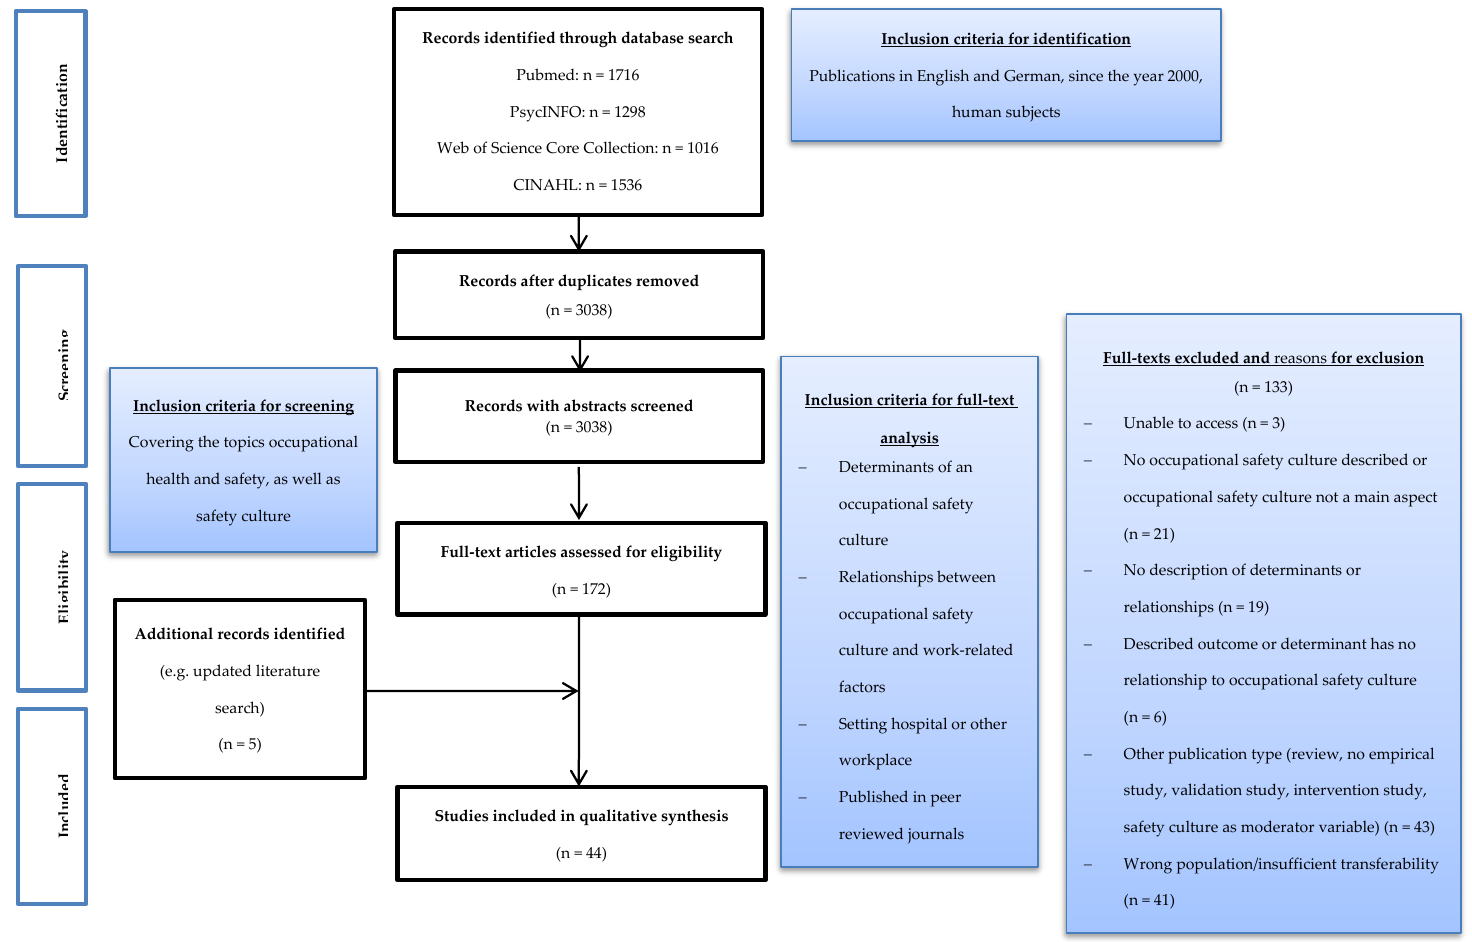
Figure 1. Study selection.